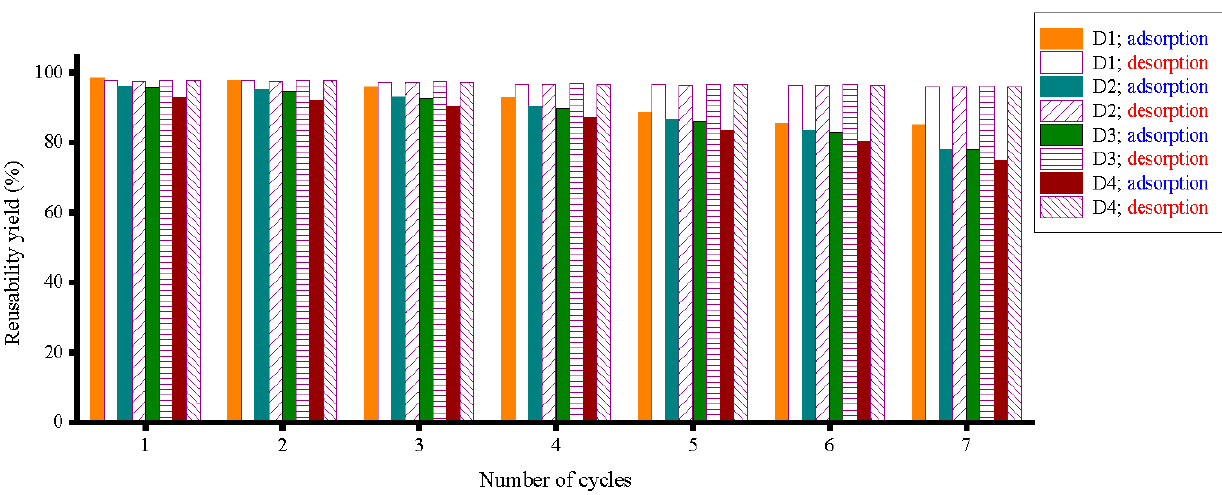
Figure 13. Reusability yield (%) of seven repeated adsorption-desorption